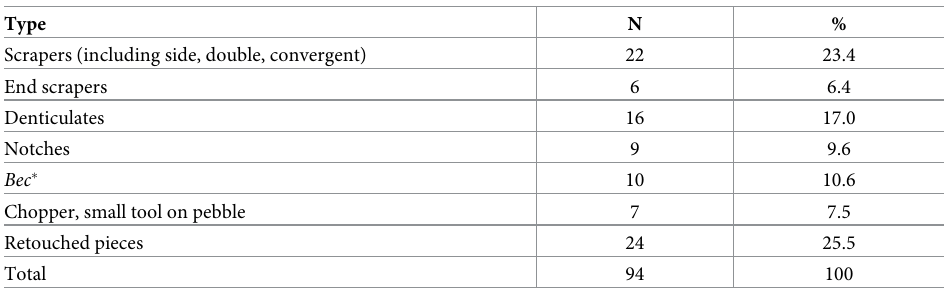
Table 6. Castel di Guido. Counts of stone small tools by major categories ( < 6 cm). Type N % Scrapers (including side, double,